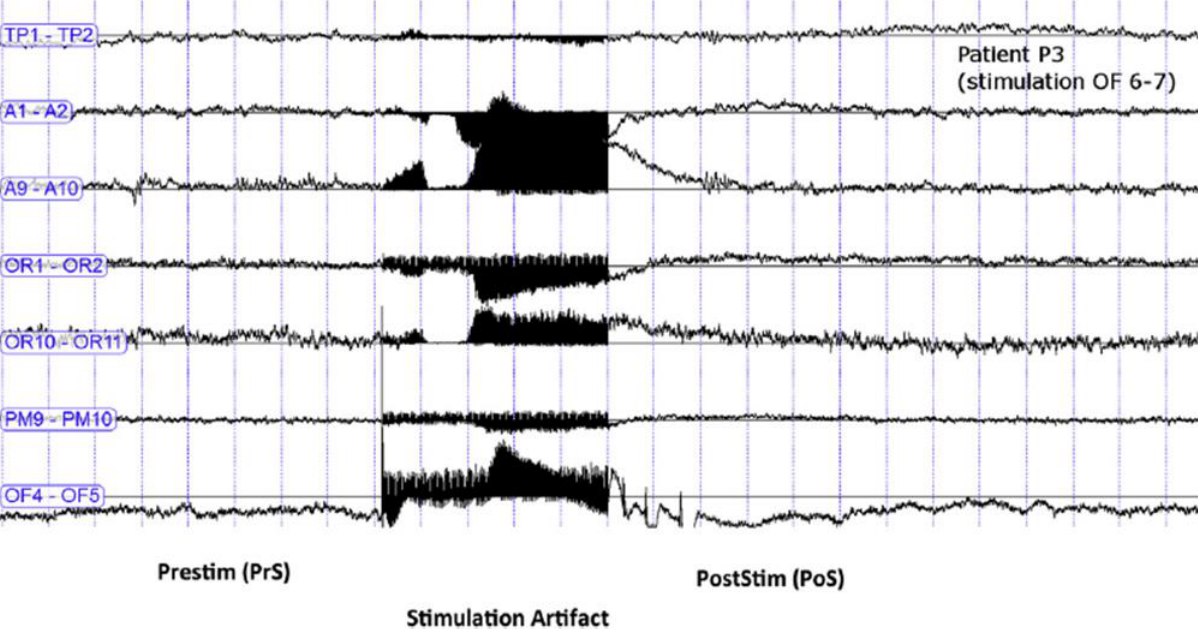
Figure 3. Stereo-electroencephalography (SEEG) recording during a stimulation inducing an ecstatic aura, in Patient 3, showing the detail of seven bipolar channels. The figure shows the SEEG signals and the artifact of electrical stimulation applied in the insula (50 Hz, 1 ms pulse width, 1.6 mA) for 5 s. There is no visible after-discharge. Each line represents a bipolar lead representative of a brain region: TP1–2: temporal pole; A1–2: amygdala; A9–10: middle temporal gyrus; 0R1–2: orbitofrontal cortex; OR 10–11: dorsolateral prefrontal cortex; PM9–10: premotor cortex; and OF4–5: anterior insula. Adapted from a Figure published in Brain Stimulation 12(5) (2019), F. Bartolomei, S. Lagarde, D. Scavarda, R. Carron, C.G. Bénar, and F. Picard. The role of the dorsal anterior insula in ecstatic sensation revealed by direct electrical brain stimulation, page 1123, Reproduced with permission from Elsevier.